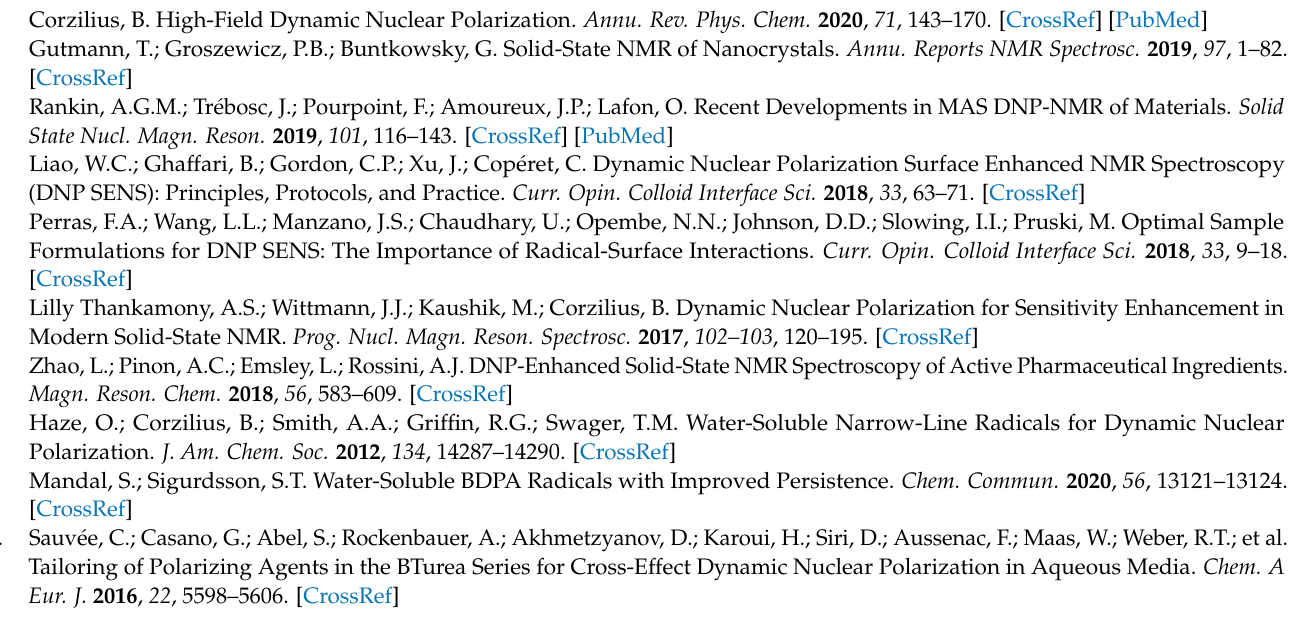
plementary Materials. Figure S1: Molecular structure of diradical 4 with the atom-labelling scheme. Displacement ellipsoids are drawn at the 30% probability level. Figure S2: Fragment of molecular chain directed along (b-c); Table S1: Intermolecular hydrogen bonds in crystals of diradical 4